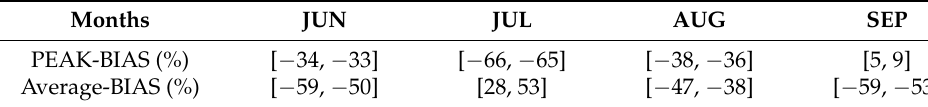
Figure 8. Extreme and average rainfall patterns analysis. Table 5. PEAK BIAS and average BIAS for E1 and E2.